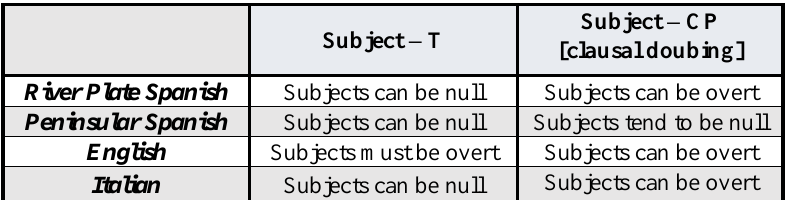
Table 2. Parameterasation of null subjects in predication